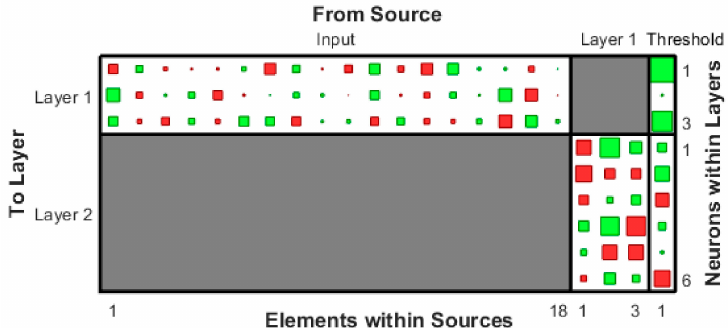
Figure 7. Hinton plot of weights and thresholds for db6 wavelet transform-based neural